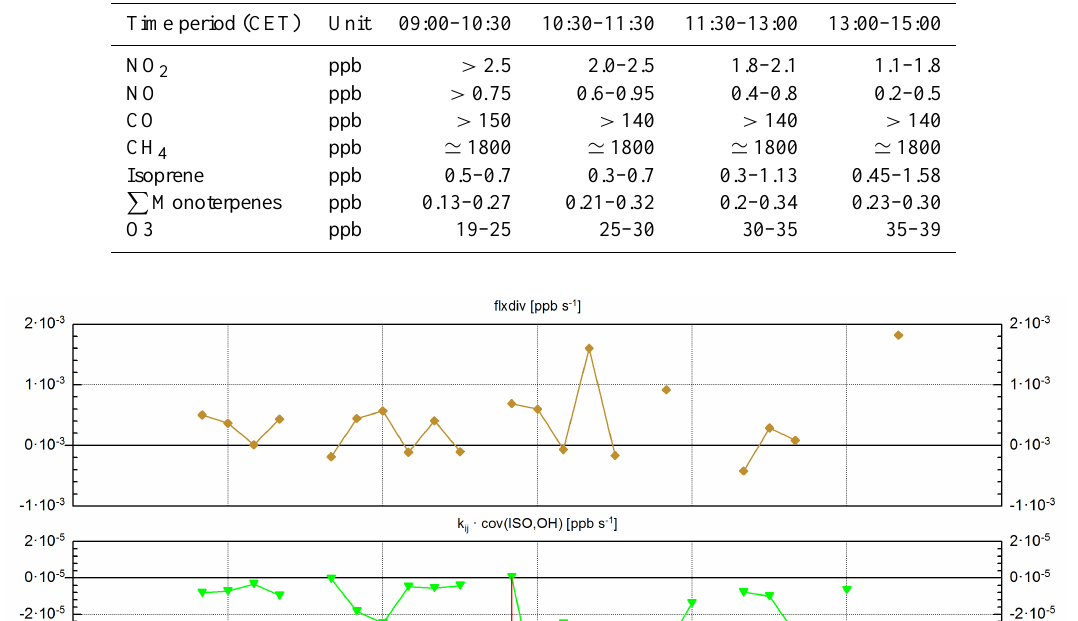
Table 1. Mean mixing ratios on 25 July 2003 (day 206) at the ECHO site.